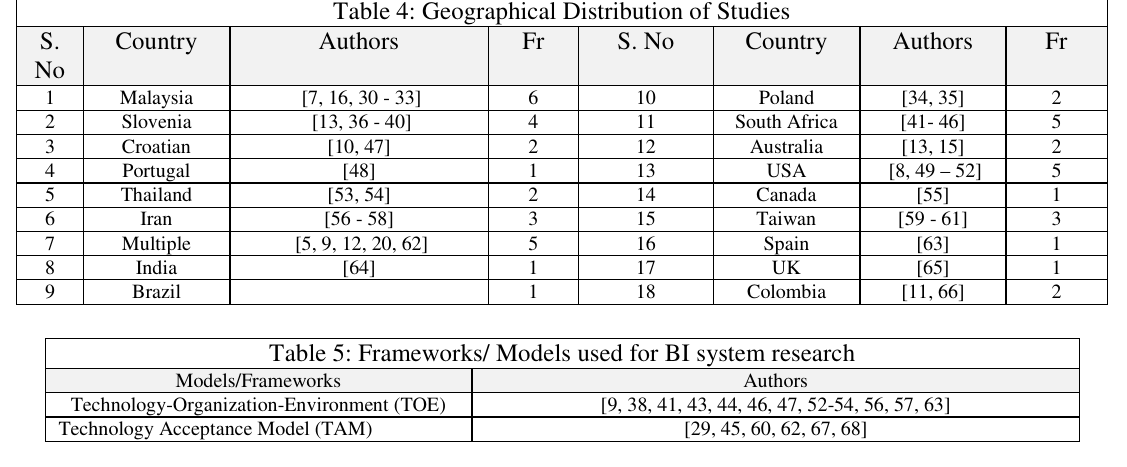
Table 5: Frameworks/ Models used for BI system research